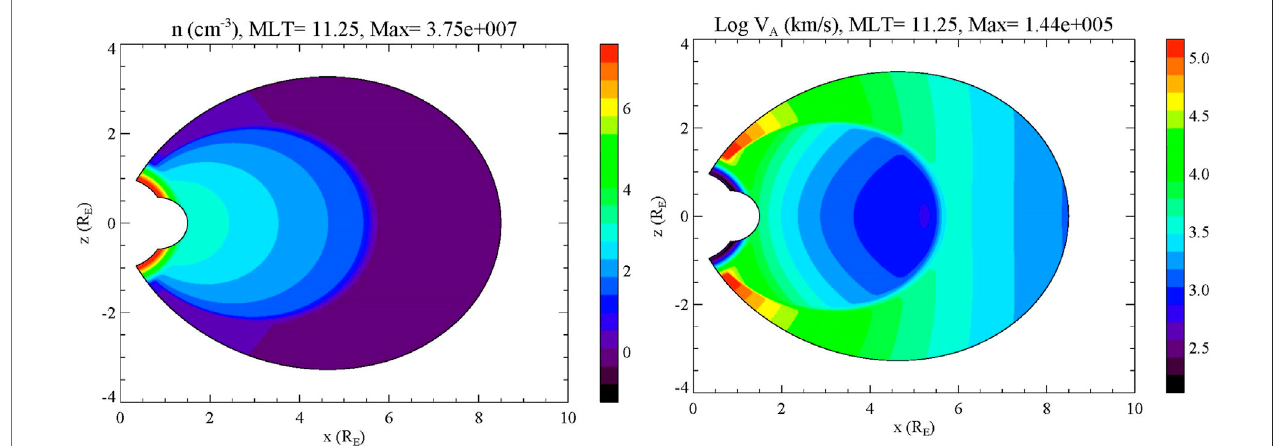
FIGURE 1 | Density (left) and Alfvén speed (right) for a dipole model of Earth ’ s